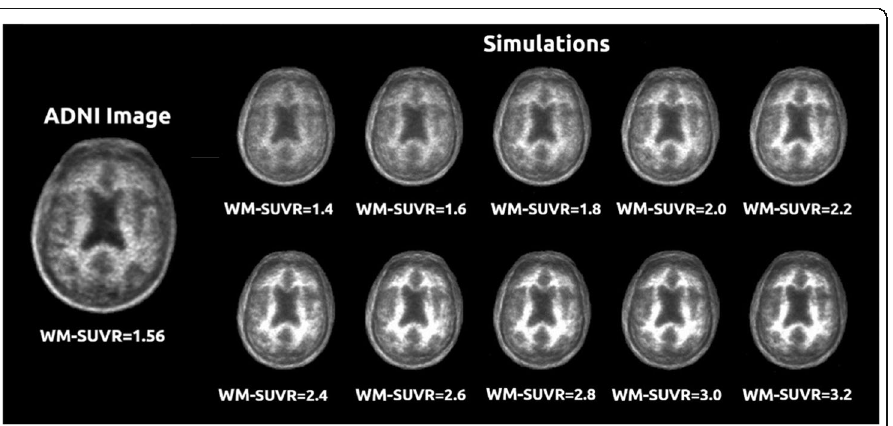
Fig. 4 Simulations of the 10 activity maps with different WM uptakes and a fixed cortex uptake for one of the simulated